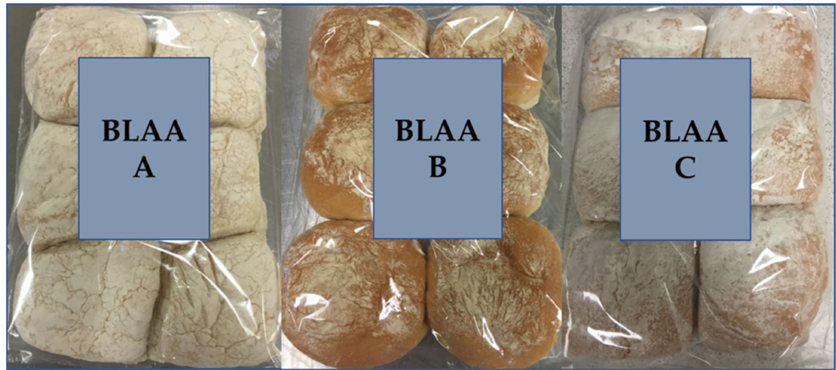
Figure 1. Appearance of the three Waterford Blaa products used in this